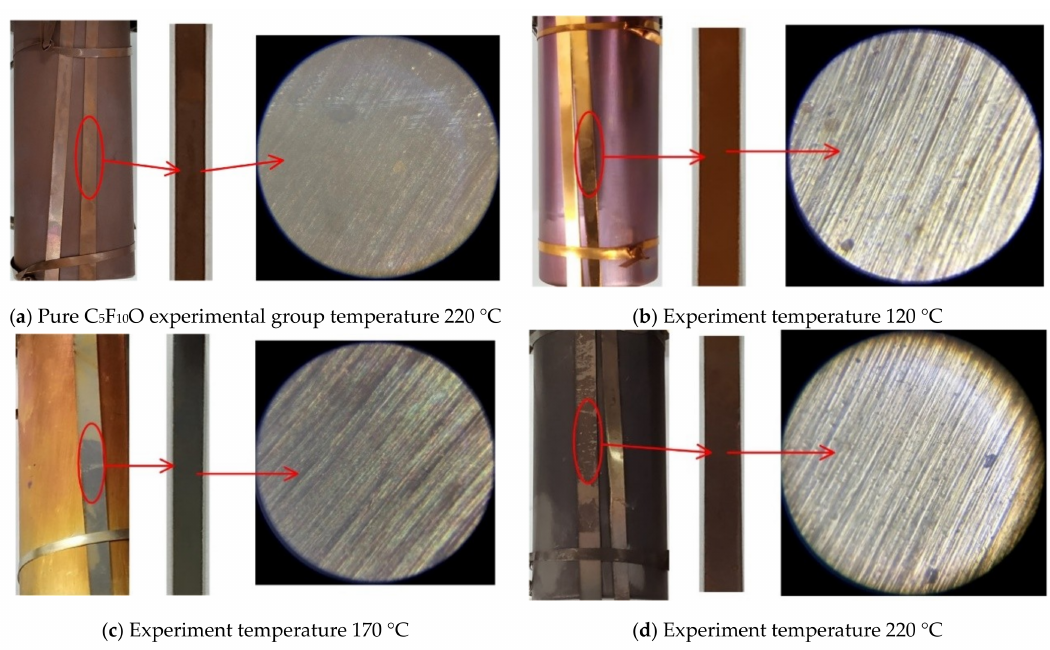
Figure 3. Surface photo of copper before and after contact with C 5 F 10 O/air gas